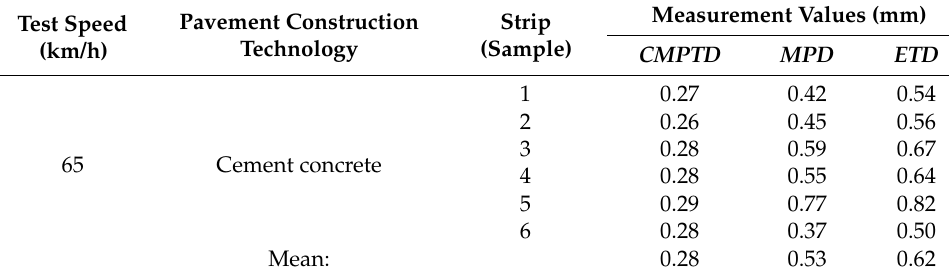
Table 15. Field tests results for cement concrete (95 km/h).